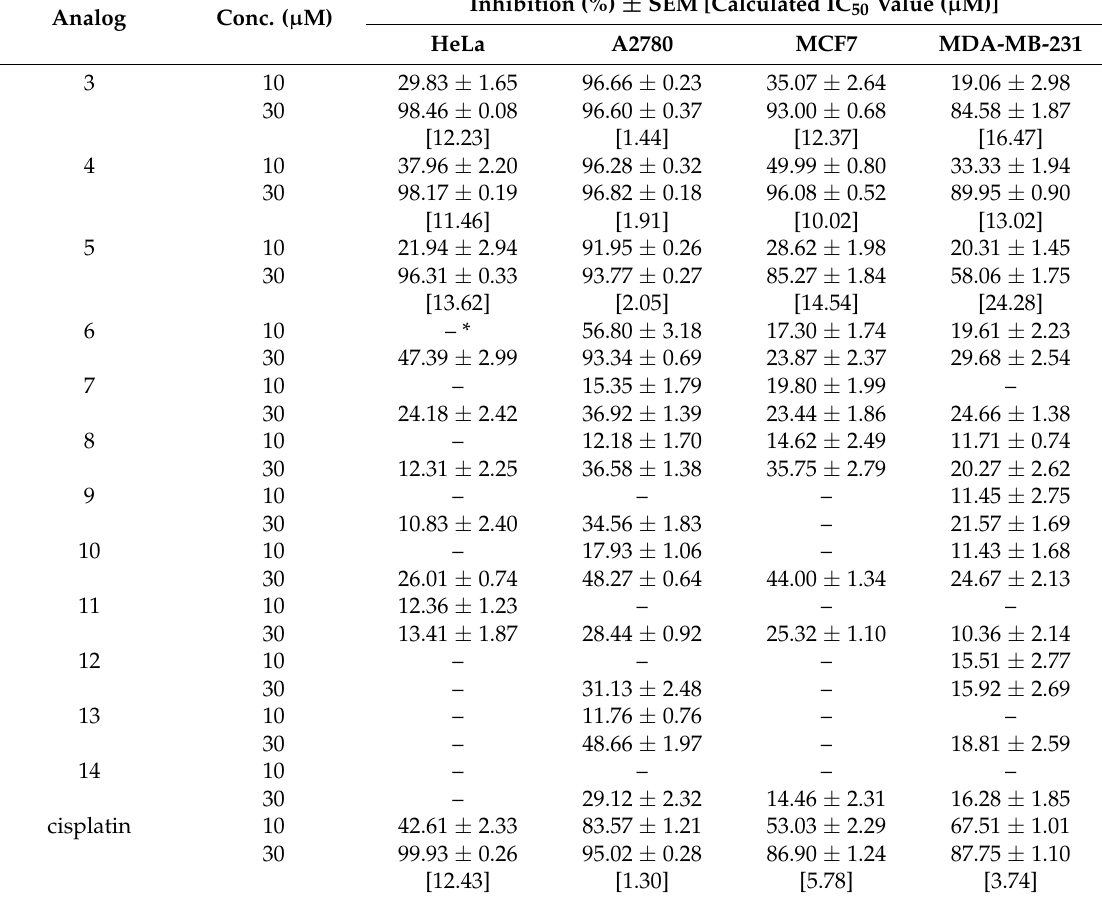
Table 2. Antiproliferative activities of the tested monoterpene